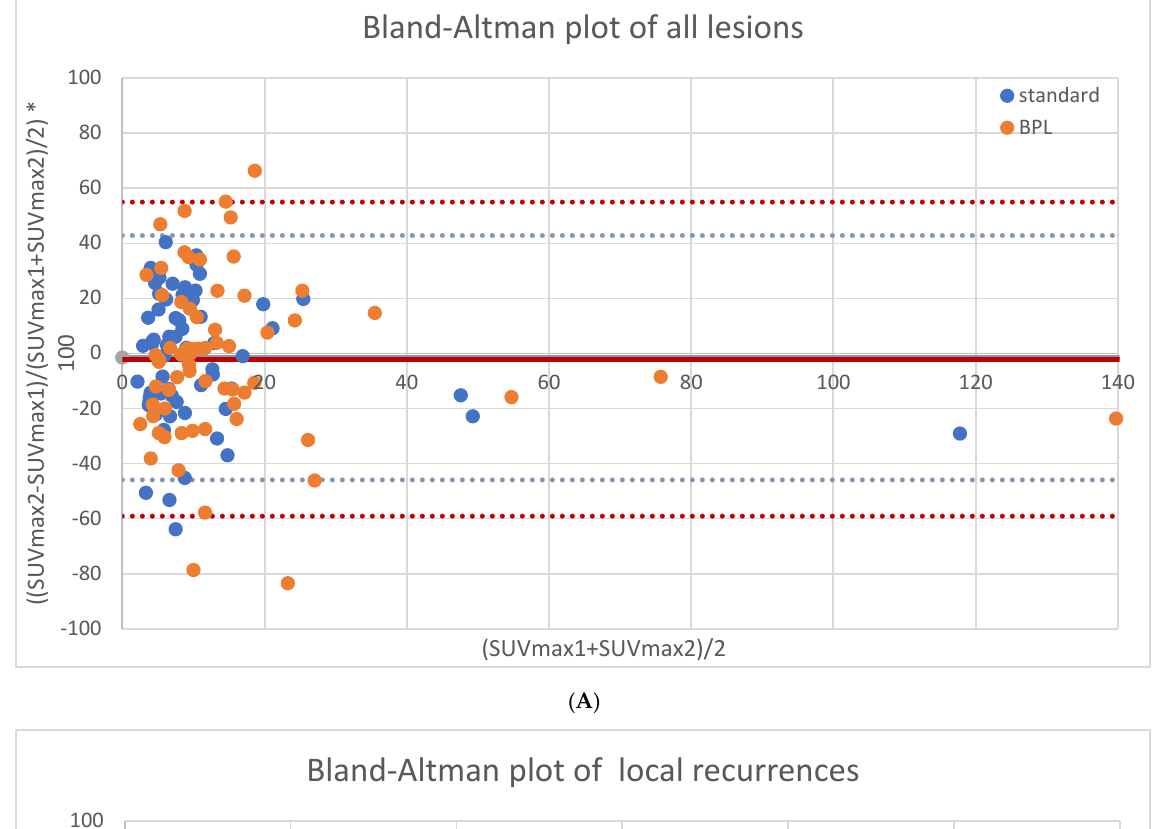
Bland-Altman plot of all lesions